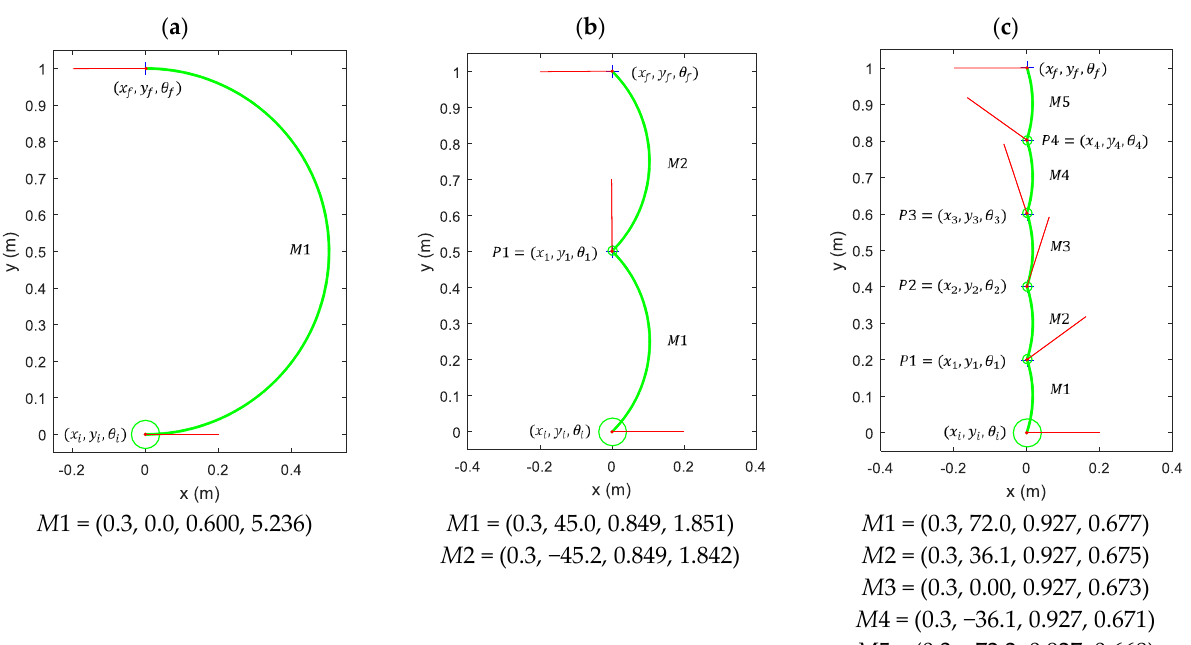
Figure 6. Representation of the motion command 𝑀 = (𝑣,𝛼,𝜔,𝑡 𝑟 ) and the mobile robot trajectory (green line) required to move from a starting point 𝑃 𝑖 (green circle) to a planned destination 𝑃 𝑓 depending on the number of intermediate waypoints defined using an interpolation procedure: ( a ) direct trajectory with only one motion command and no intermediate waypoints; ( b ) trajectory with one intermediate waypoint P1 that requires the computation of two motion commands; ( c ) trajectory with four intermediate waypoints P1, P2, P3 and P4 that require the computation of five motion commands.